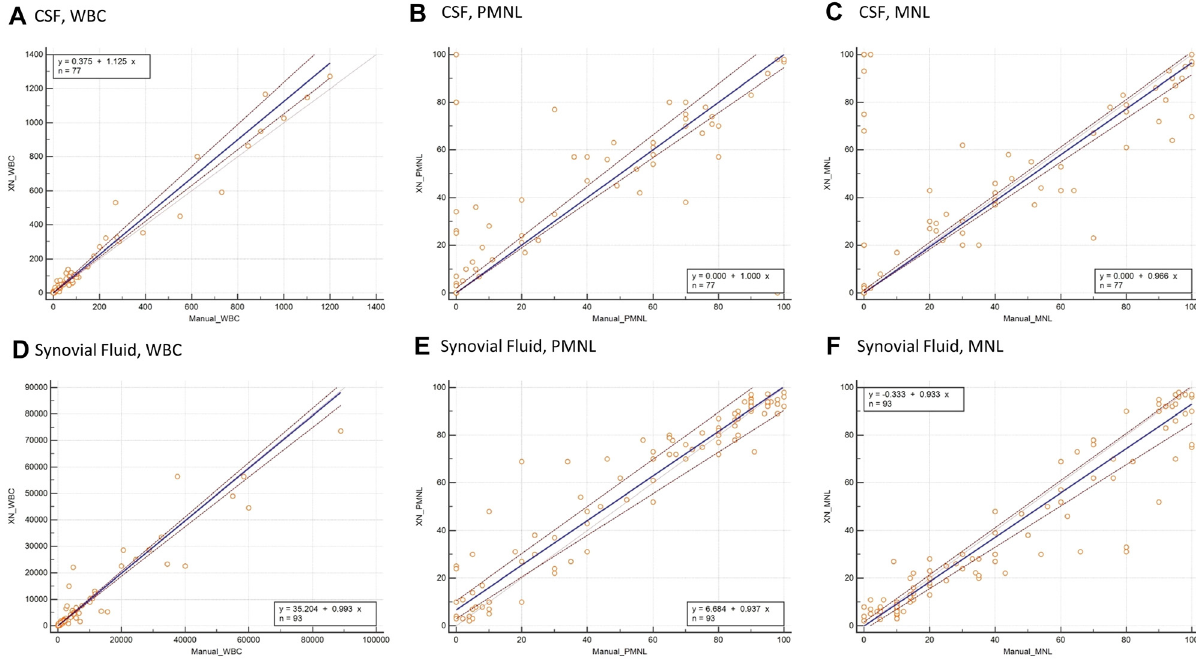
Figure 1: Passing-bablok plots for the CSF and synovial fluids. CSF, cerebrospinal fluid; MNL, mononuclear leukocytes; PMNL, polymorphonuclearleukocytes;WBC,whitebloodcells.Identitylines(y=x)aregray,con fi denceintervalsaredashedredandregressionlines are blue.